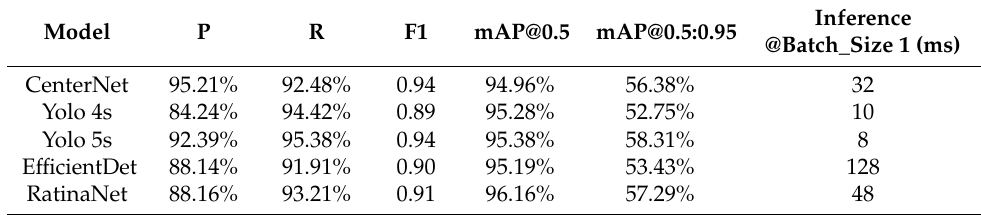
Table 1. Comparison of object detection models.